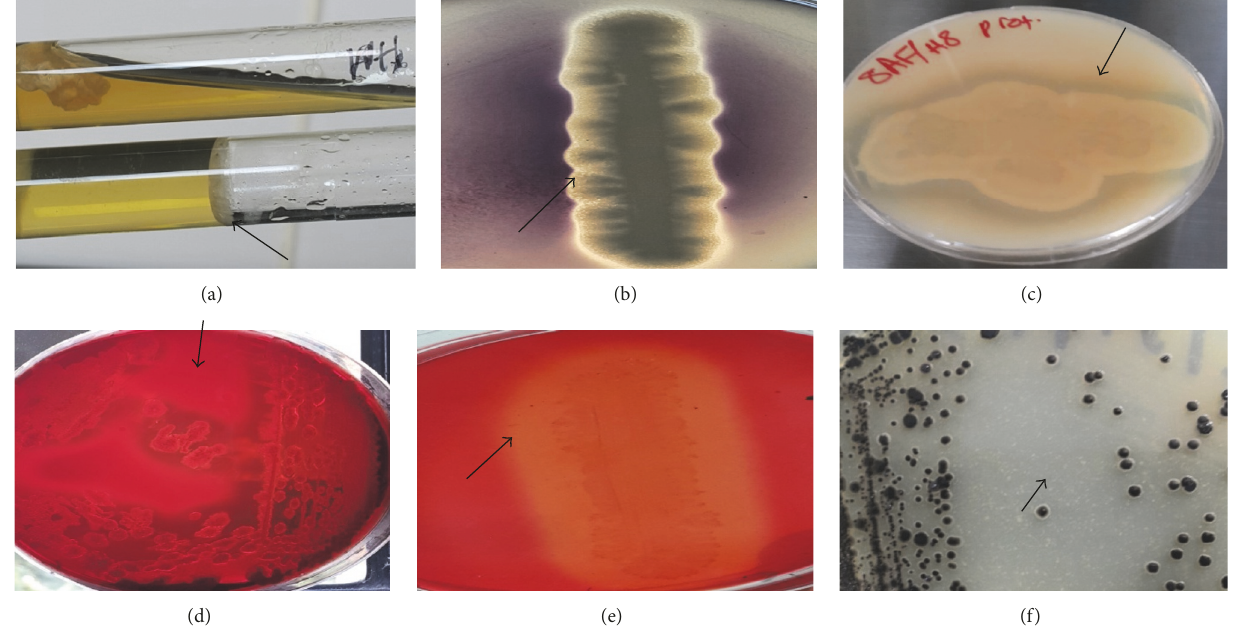
Figure 4: Enzyme activity of Bacillus species isolated from Jordanian hot springs. (a) Gelatinase activity, (b) amylase activity, (c) protease activity, (d) beta-hemolytic activity, (e) cellulase activity, and (f) lecithinase activity. Black arrows represent enzyme